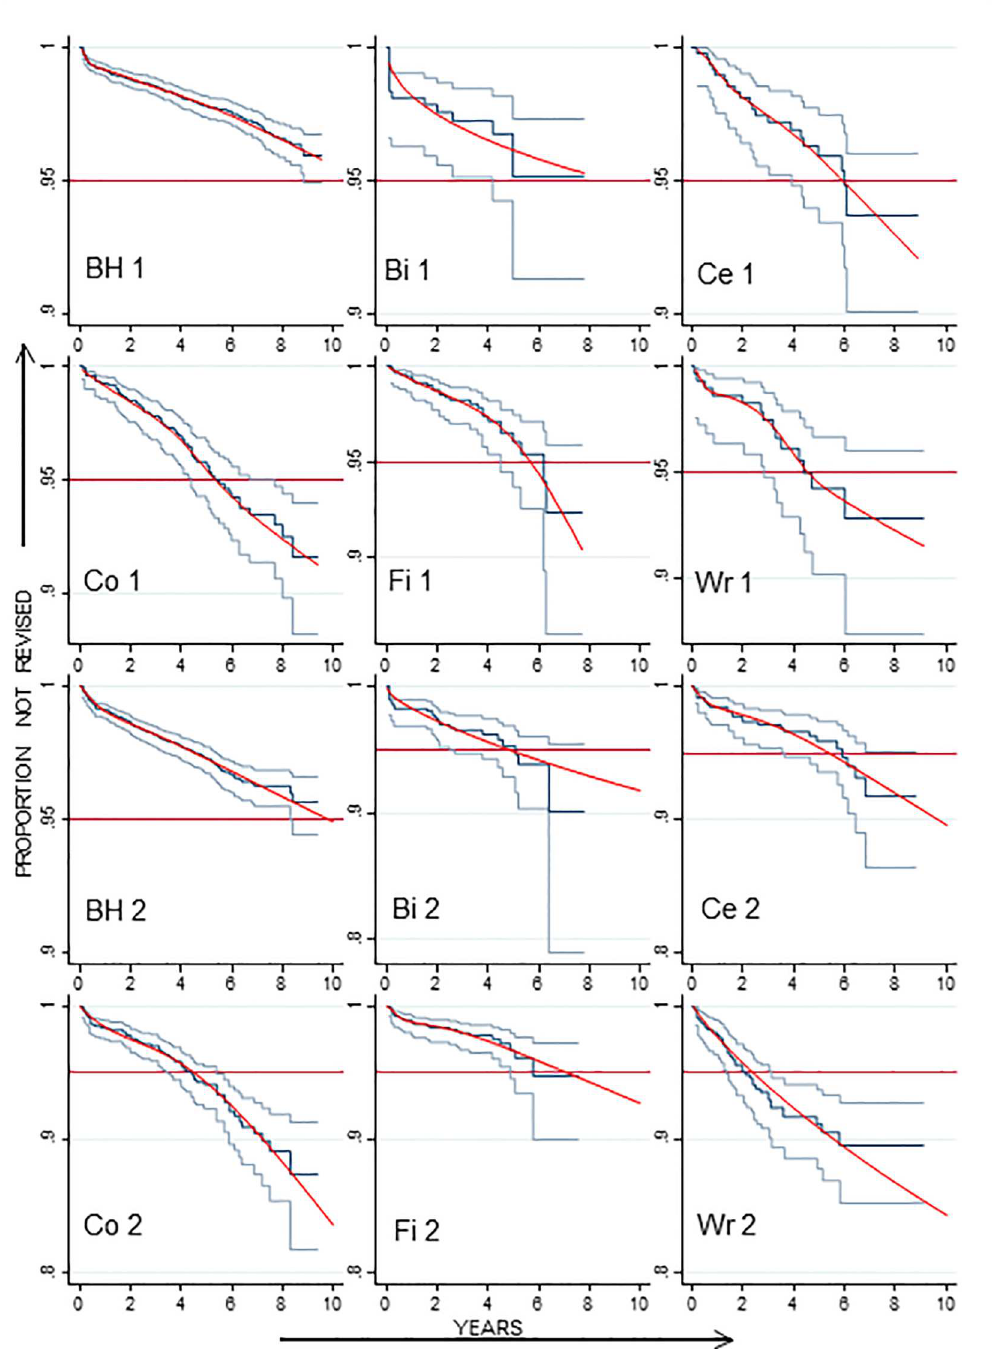
Fig 2. Kaplan-Meier revision plots (95% CI) and flexible parametric models for different manufacturer’s RS devices implanted in men graded as ASA 1 (upper panel) or ASA 2 (lower panel). BH = Birmingham Hip; Bi = Biomet; Ce = Centerpulse; Co = Corin; Fi = Finsbury; Wr = Wright